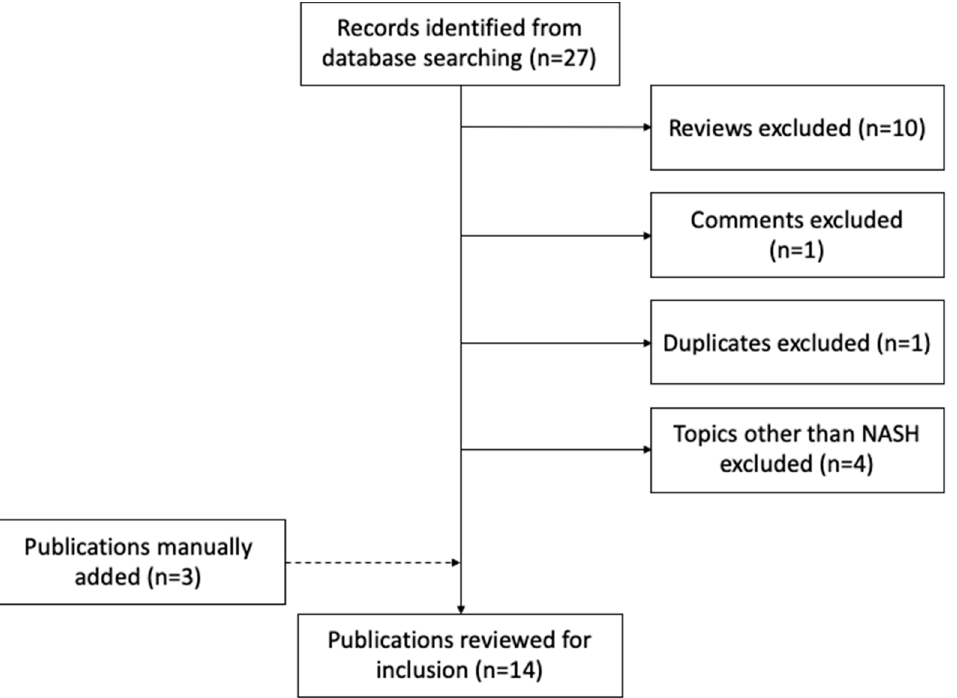
Figure 1. Flow chart of studies identified, excluded, and included. Table 4. Overview of multi-omics studies in NASH/NAFLD.